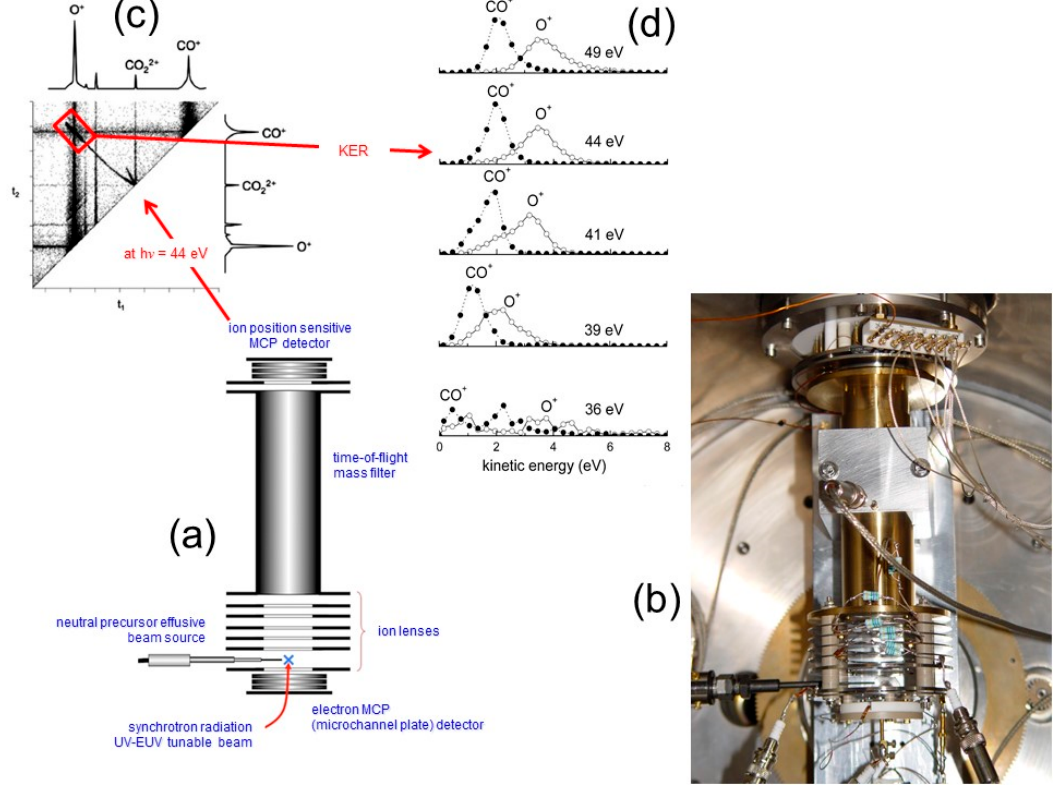
Figure 6. The PEPIPICO (photoelectron–photoion–photoion coincidence) detector coupled with TOF mass spectrometer especially designed to measure the spatial momentum components of product fragments ions in the double photoionization experiments [72]: a scheme ( a ) and a picture ( b ) of the device; ( c ) an example of a typical recorded coincidence spectrum with the relative mass spectra collected in the double photoionization experiment of carbon dioxide at a photon energy of 44 eV. In red color is pointed out the region of the coincidences signal used for the evaluation of the KER distributions for CO + and O + fragment ions generated from the Coulomb explosion of the CO 2 + metastable dication; ( d ) the KER distributions for CO + / O + pair of fragment ions as a function of the investigated photon energy [77] indicating that O + ions are produced with a high kinetic energy content ranging between 2.2–3.8 eV.